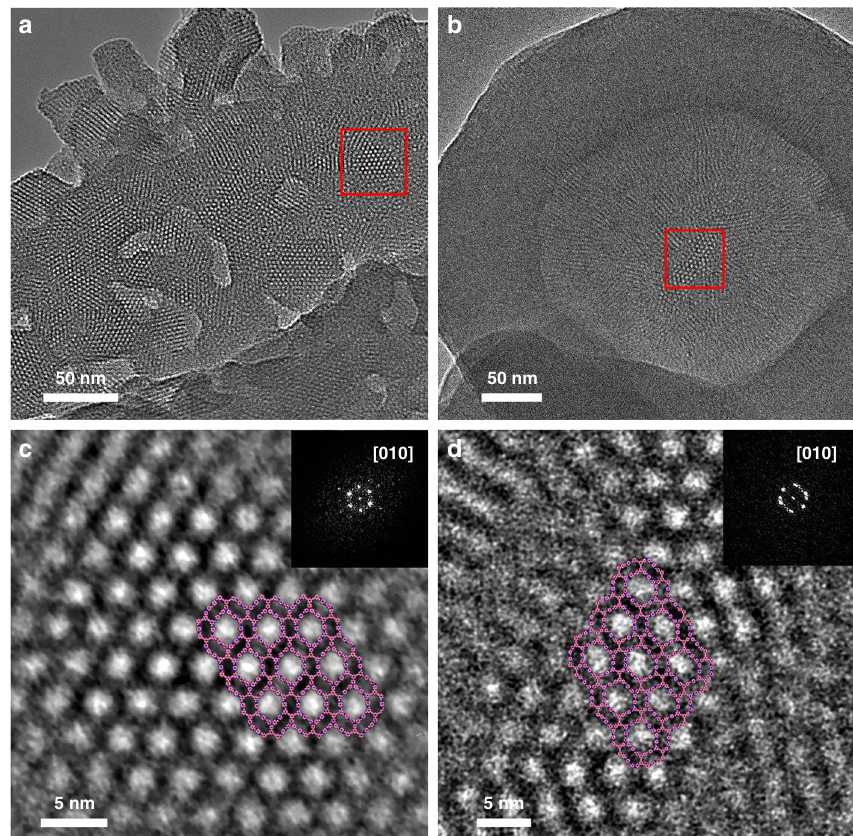
Fig. 7 TEM analysis. TEM images of a Tri-COF-DAB and b Tetra-COF-DAB, and HR-TEM images of c Tri-COF-DAB and d Tetra-COF-DAB focusing on the regions marked by the red squares in a and b at a higher resolution. The images inserted in the upper right corners are their corresponding FFT patterns, and the structure projections in HR-TEM images are along the b -axis and the structural models are inserted in the